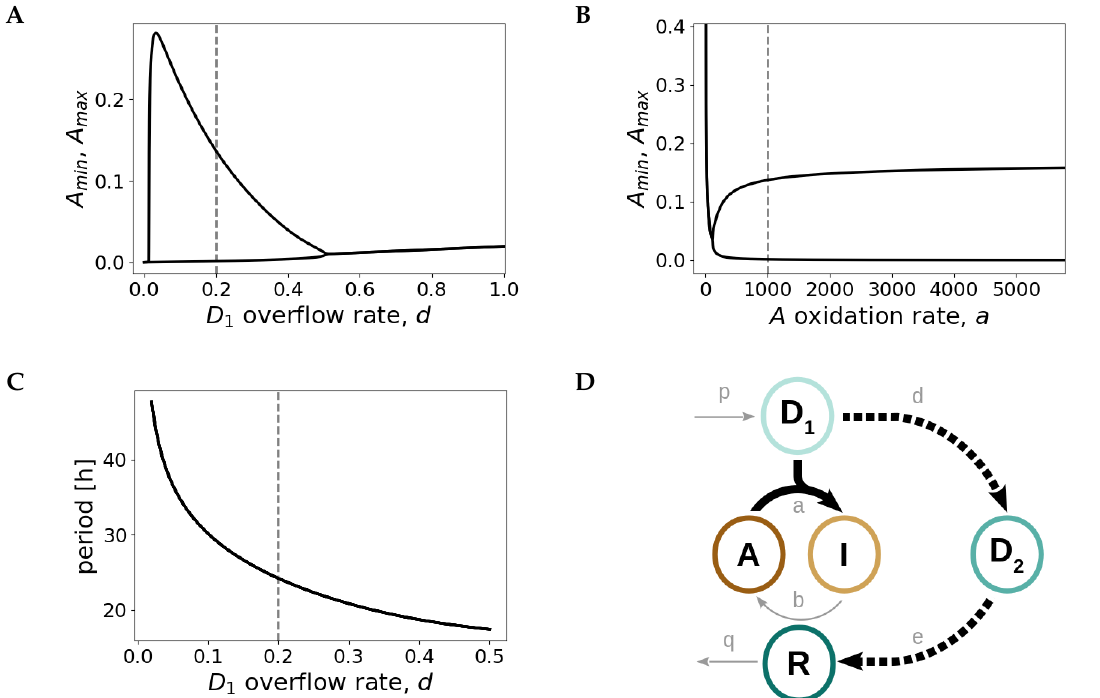
Figure 3. Fast A inactivation followed by a slow negative feedback loop is the design principle of the Prx3/Srx redox oscillator. Bifurcation diagrams as a function of the model parameters d ( A ) and a ( B ). At d = 0.02 and a = 120 self-sustained oscillations emerge. A min and A max represent the minimum and maximum values of A in the oscillatory regime. ( C ) Variation of period as a function of d . The curves shown in panels ( A – C ) are obtained for the default parameter set given in the caption of Figure 4. The dashed gray lines depict the default parameter values given in the caption of Figure 4. ( D ) Sketch of the core backbone for I / R redox oscillations: fast D 1 -induced A inactivation (continuous thick line) followed by a slow D 1 − D 2 − R negative feedback loop (dashed